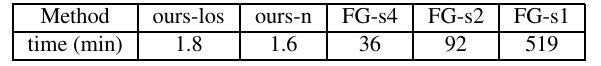
Table 1: Processing times for filtering the complete Fountain d ataset of our algorithm and the method proposed in (Fuhrmann and Goesele, 2011).